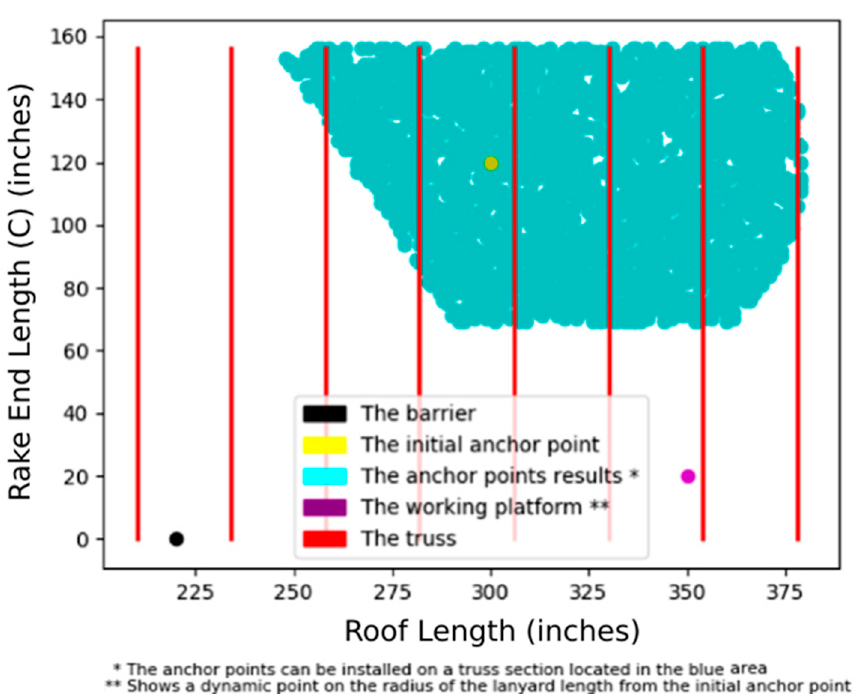
Figure 8. The tool’s graphical output of the results (for the gable roof scenario).